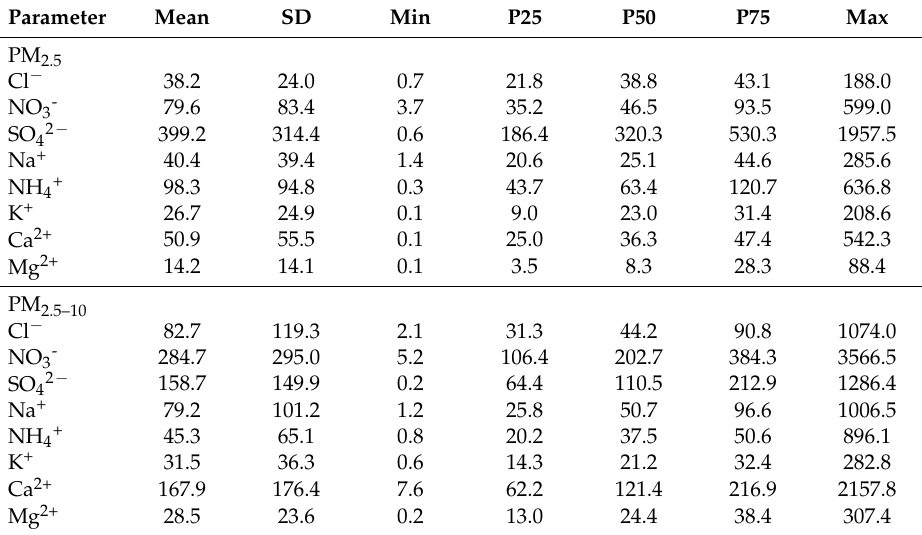
Table 2. Descriptive statistics of the PM 2.5 and PM 2.5–10 chemical constituents (ng/m 3 ). São José dos Campos. Brazil, 2010–2011.